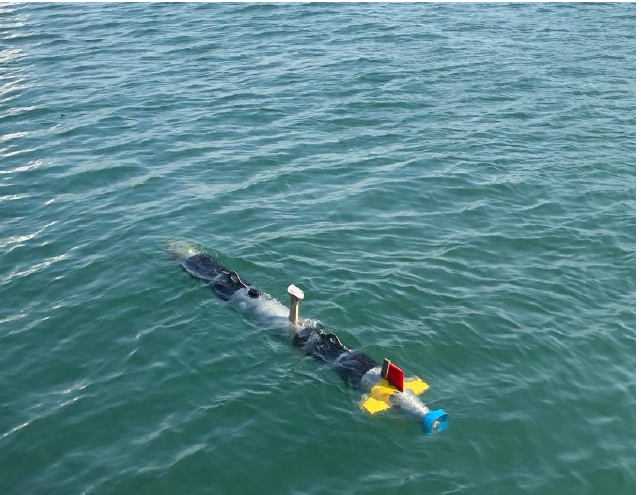
Figure 16. Sailfish AUV in sea